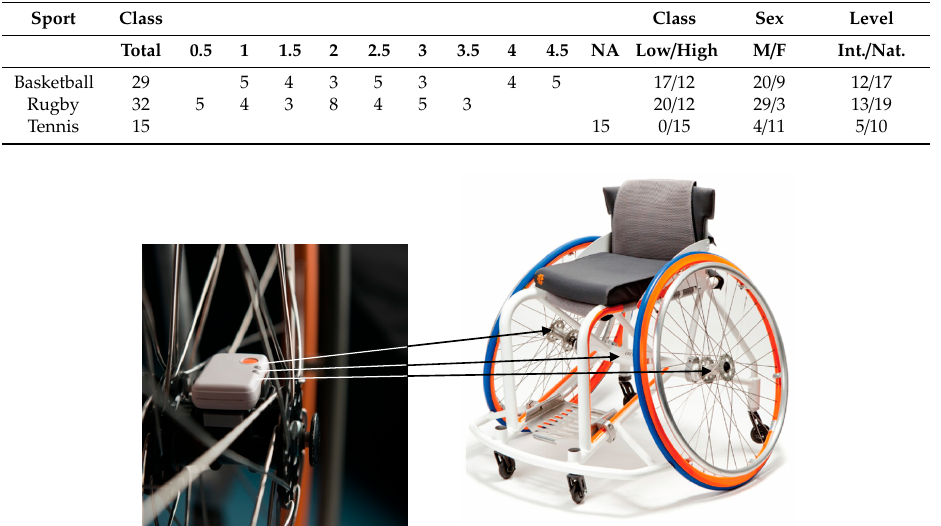
Table 1. Participant characteristics. For the class, additional grouping was applied with a low-class group consisting of class 1–2.5 for wheelchair basketball and 0.5–2 for wheelchair rugby. The high- class group consisted of 3+ for wheelchair basketball, 2.5+ for wheelchair rugby and all athletes for wheelchair tennis.